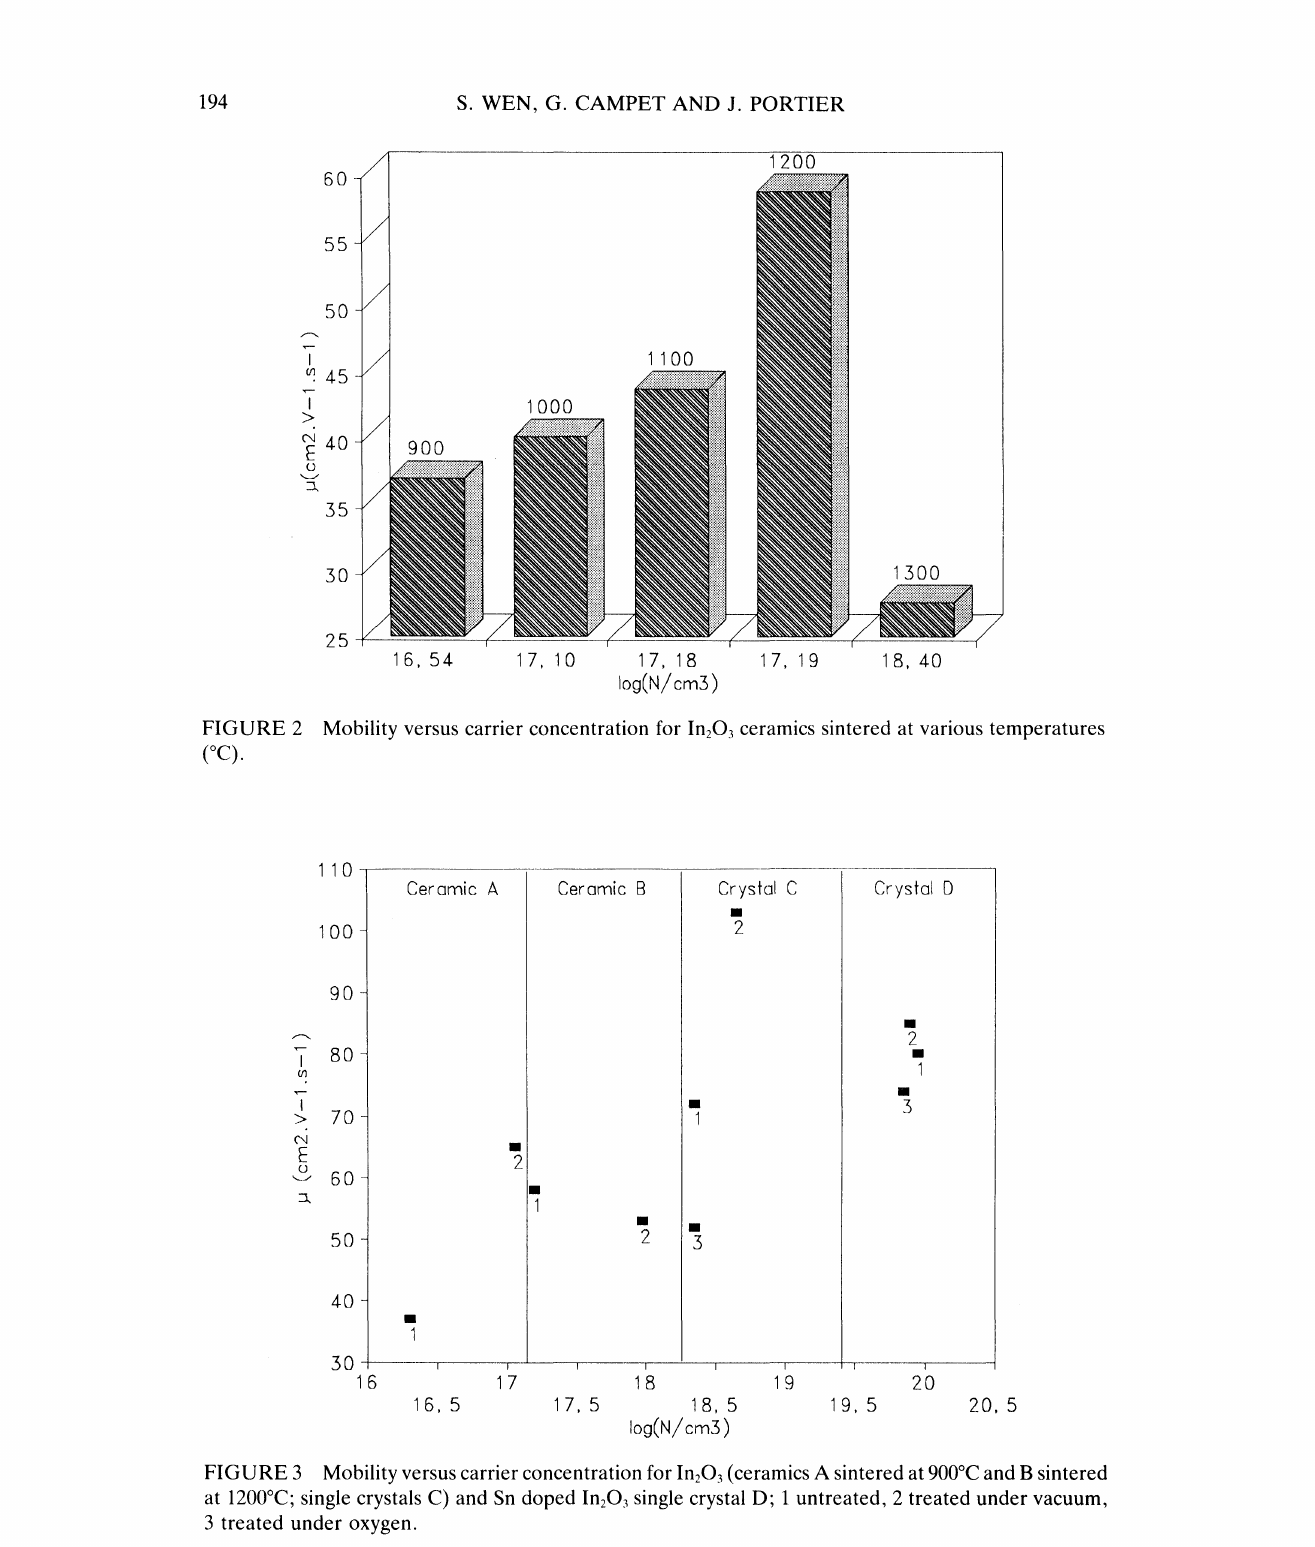
FIGURE 3 Mobility versus carrier concentration for In.,O3 (ceramics A sintered at 900C and B sintered at 1200C; single crystals C) and Sn doped In203 single crystal D; untreated, 2 treated under vacuum, 3 treated under